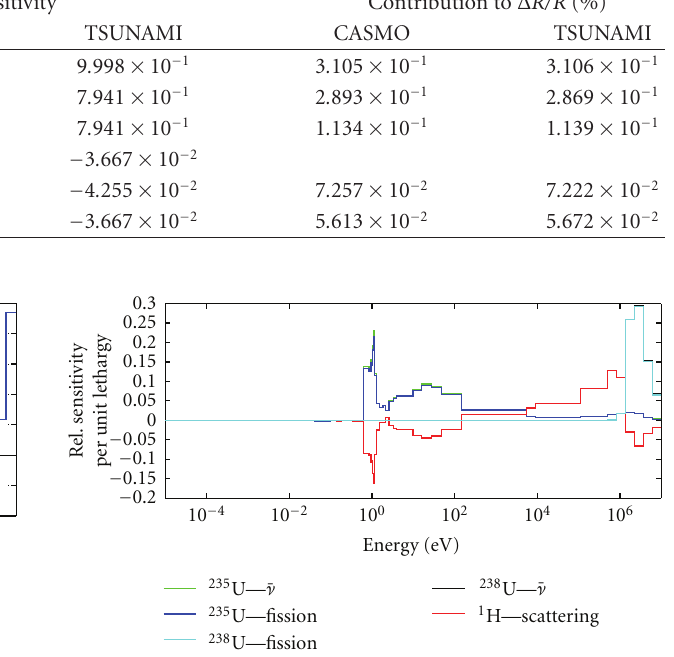
Figure 5: Volume-averaged generalized adjoints corresponding to the responses ν Σ f,1 and ν Σ f,2 .